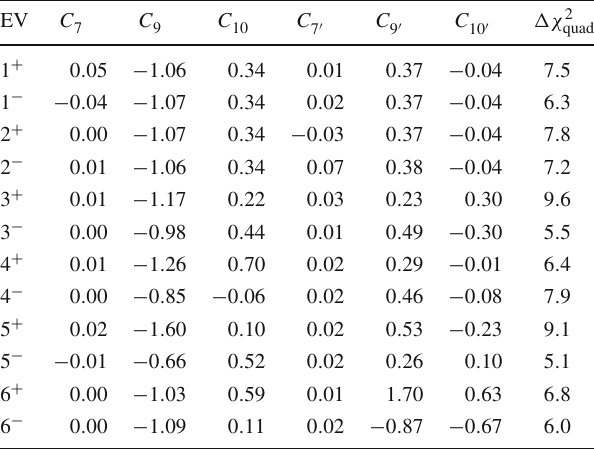
Table 10 Parameter sets obtained from the intersections of the SVD directions with the exact 1 σ surface (hence (cid:11)χ 2 exact = 7 .